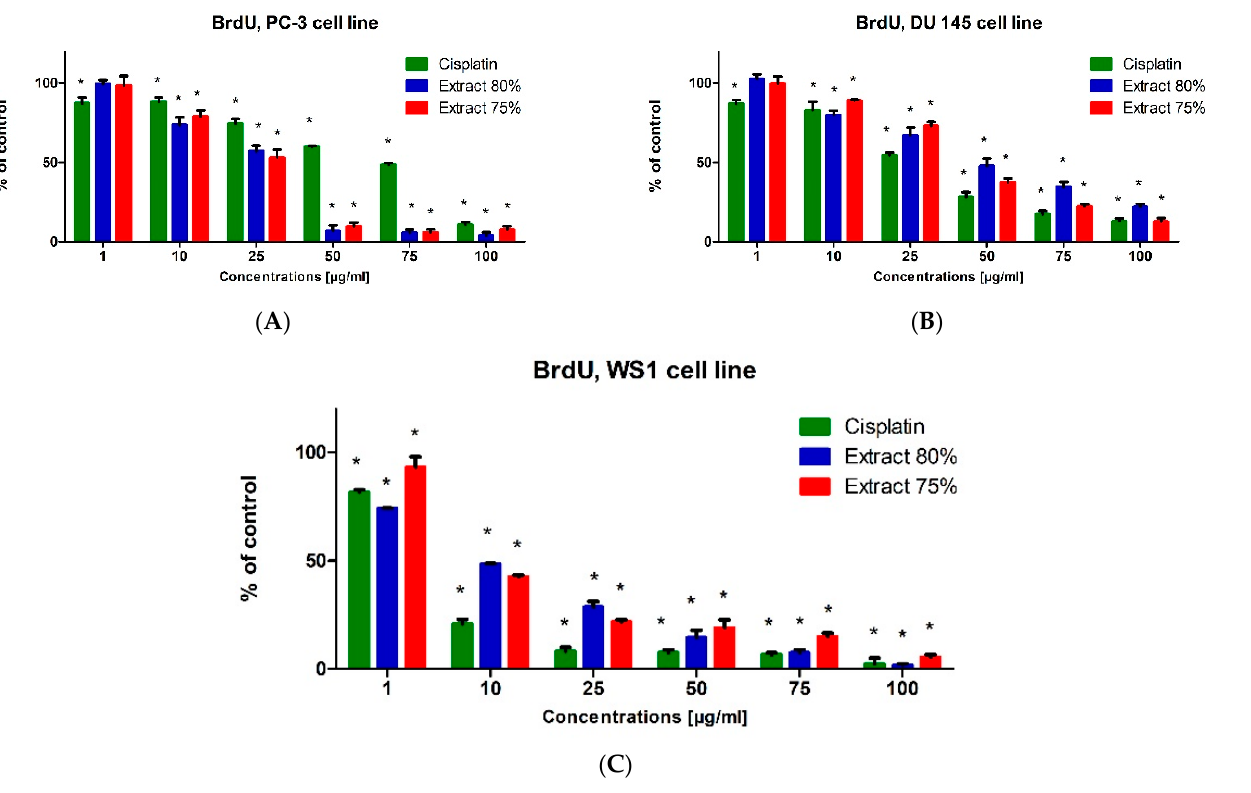
Figure 6. Effect of cisplatin, and 75% and 80% propolis extracts on DNA synthesis of PC-3 ( A ), DU 145 ( B ) and WS1 ( C ) cells, determined using the BrdU test. Results are presented as mean percentage values (% of control) ± SDs (mean value of control = 100%). Values are reported as statistically significant compared with control at * p < 0.05 (one-way ANOVA with Tukey’s post hoc test).